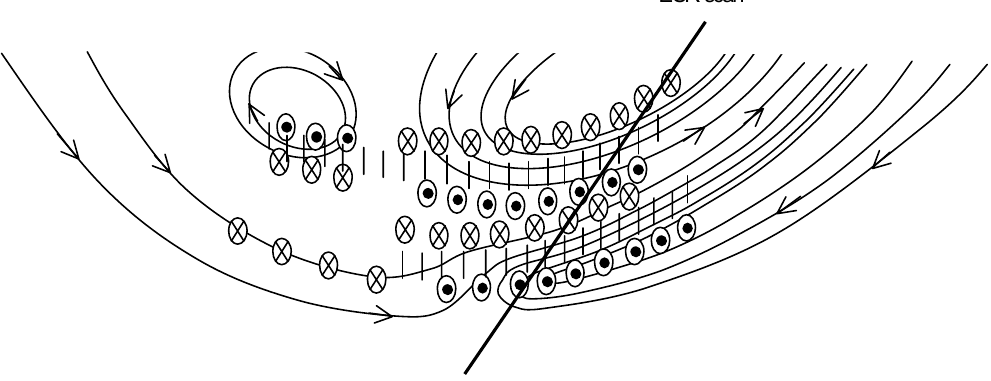
Fig. 6. Schematic diagram showing the anticipated general flow on the dayside under conditions of mid clock angle as a function of MLT and magnetic latitude. The MLT noon meridian extends down the centre of the figure with latitude decreasing from top to bottom. The arrowed curves show possible flow streamlines, and the circled dots and arrows represent the anticipated upward and downward field-aligned currents, respectively. Likely regions of auroral precipitation are shown by the hatched regions. A possible location of the ionospheric intersection of the ESR scan is shown by the straight